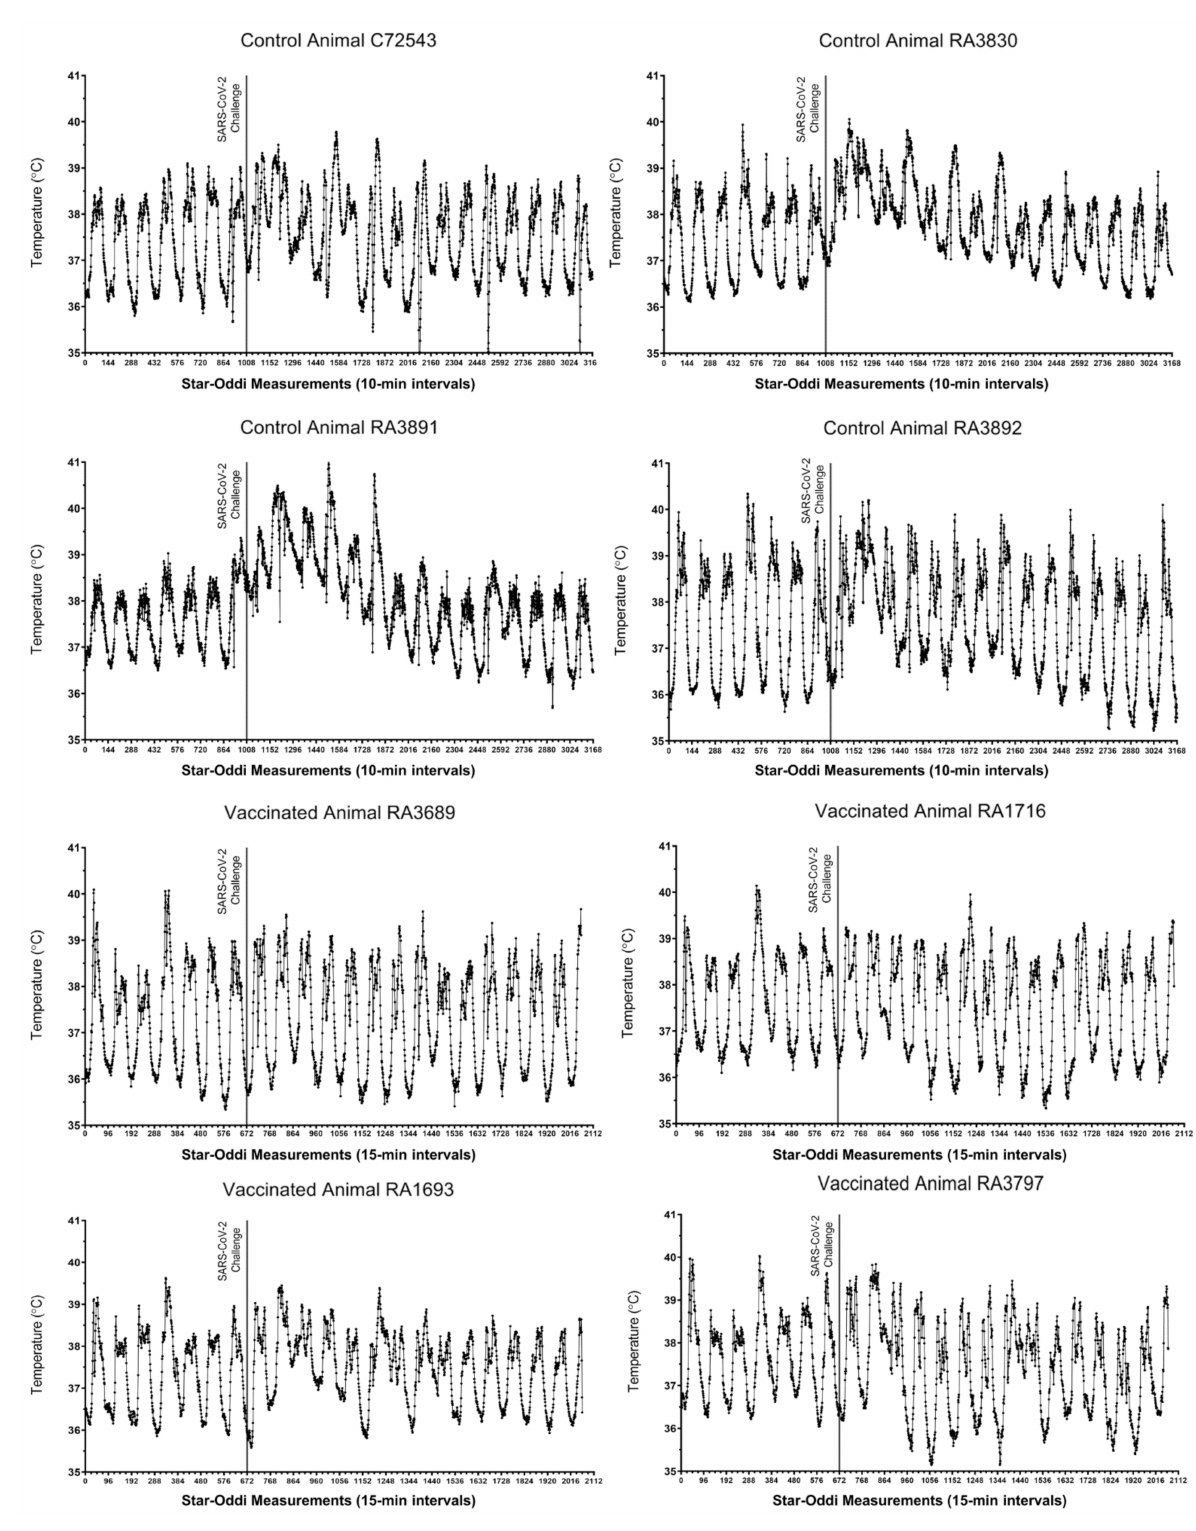
Figure 2. Core body temperature alterations in control and vaccinated macaques following SARS-CoV-2 challenge. For each animal, seven days of pre-challenge baseline temperature measurements are shown. Each tick on the x-axis represents 6 h or 36 individual logger